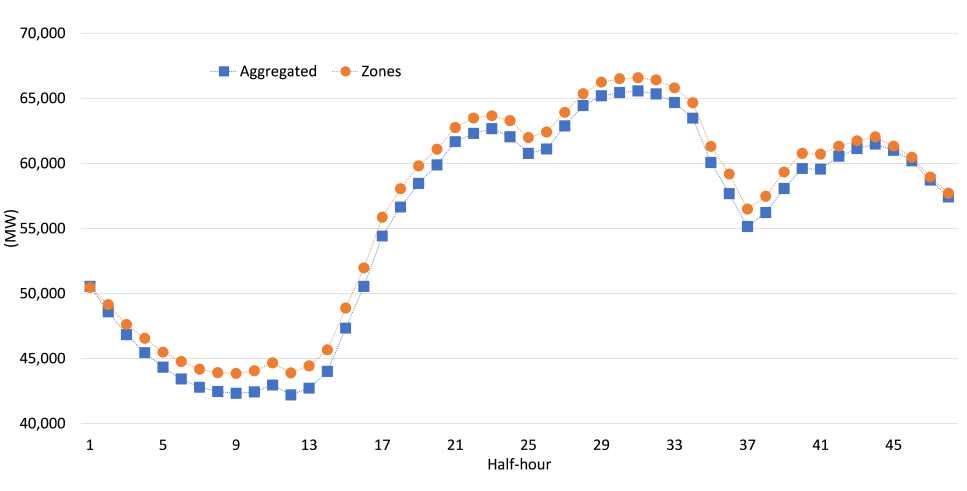
Figure 10. Hydro generation in Case 1 Trial